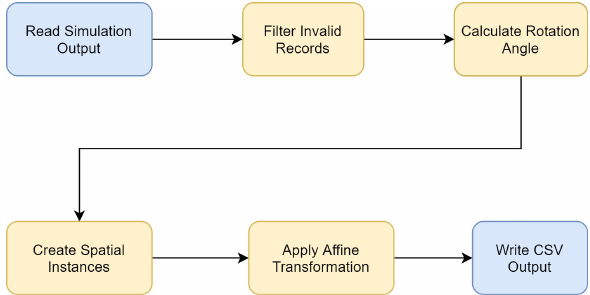
Figure 7. The conceptual model of the Feature Manipulation Engine (FME) workbench used for transforming all simulation results in the same north oriented reference system.